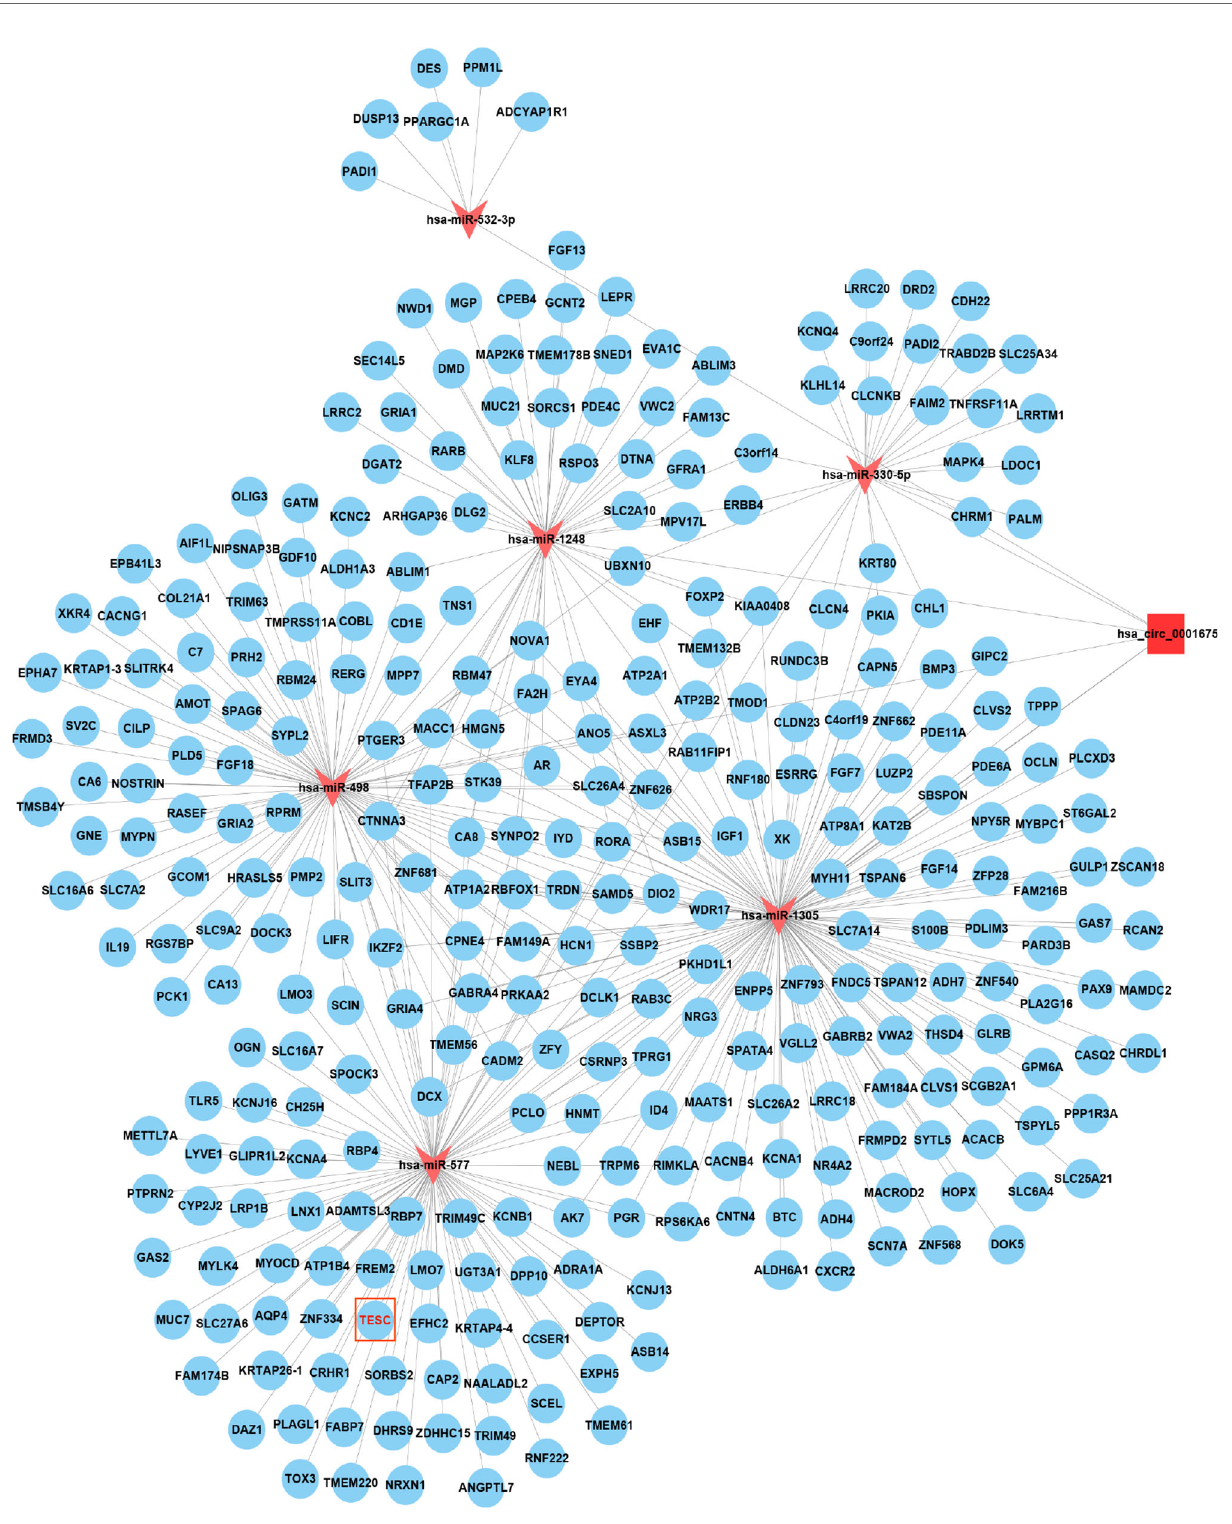
Frontiers in Oncology |